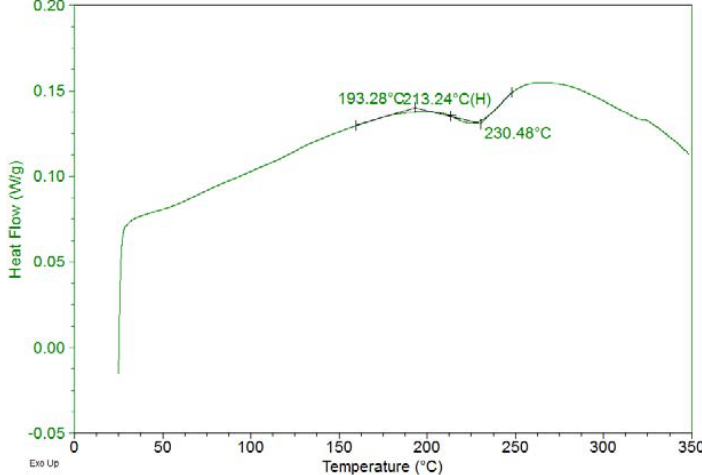
Figure A1. DSC trace of epoxy–matrix CFRE used in study.